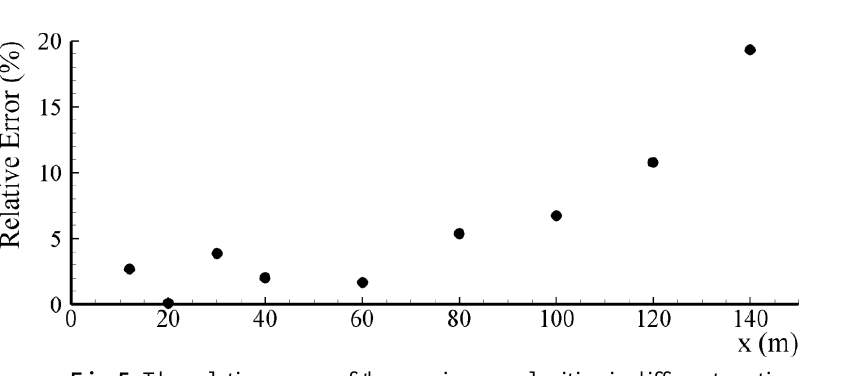
Fig. 5. The relative errors of the maximum velocities in different sections. Table 1. Primary detail of two experiments of series A and B conducted by Ead and Rajaratnam (2002).